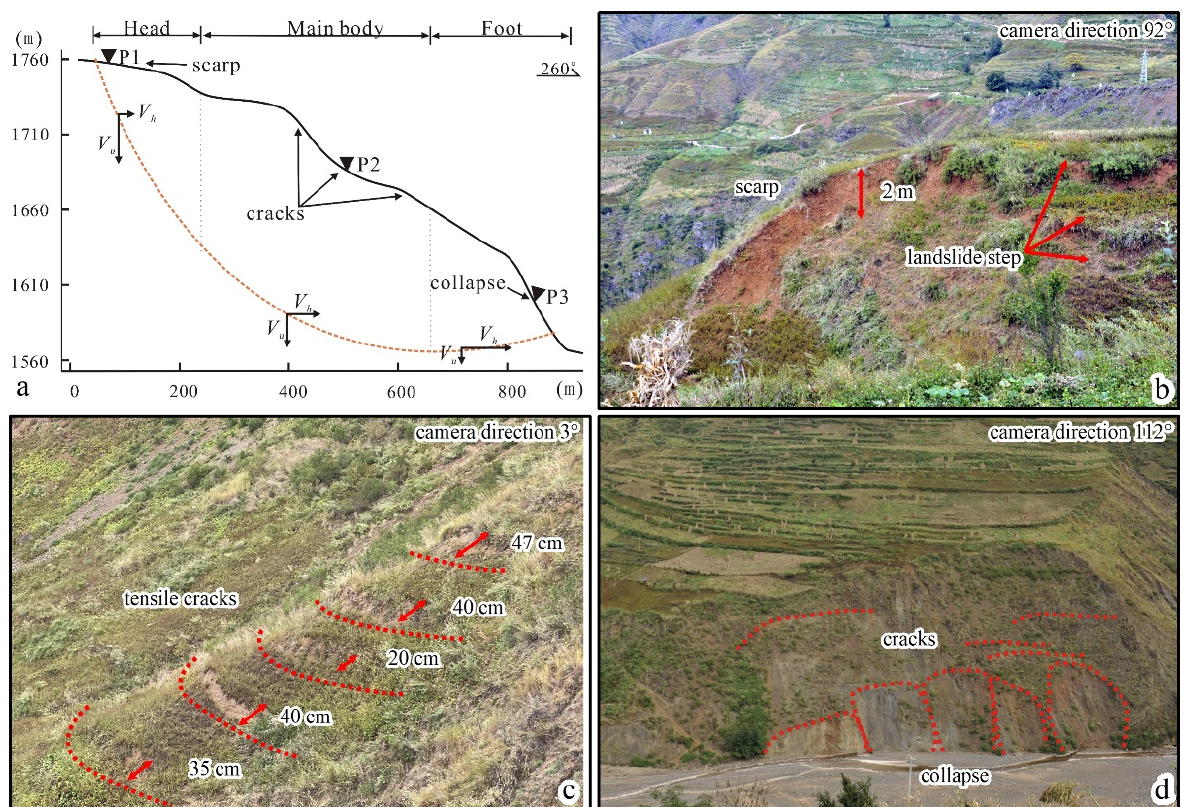
Figure 9. ( a ) Landslide profile I-I’ and location of field survey points; ( b ) deformation in the head of XMT landslide (corresponding to point P1); ( c ) tension cracks in the main body of XMT landslide (corresponding to point P2); ( d ) tension cracks and small collapse at the foot of XMT landslide (corresponding to point P3).